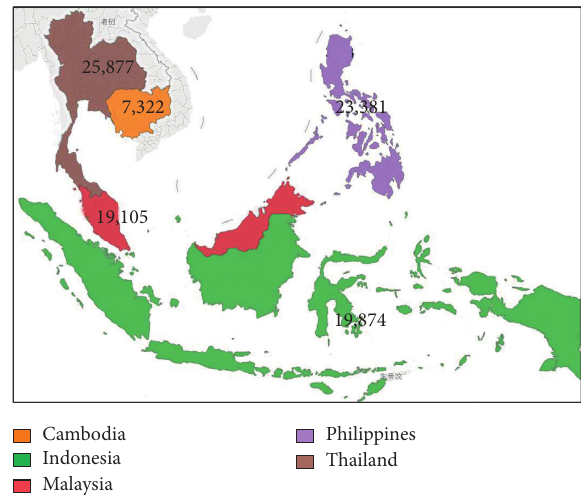
Figure 7: Figure 7Mention counts of protest events occurring in Cambodia, Indonesia, Malaysia, Philippines, and Thailand extracted from GDELT between January 1, 2001, and February 29, 2016.